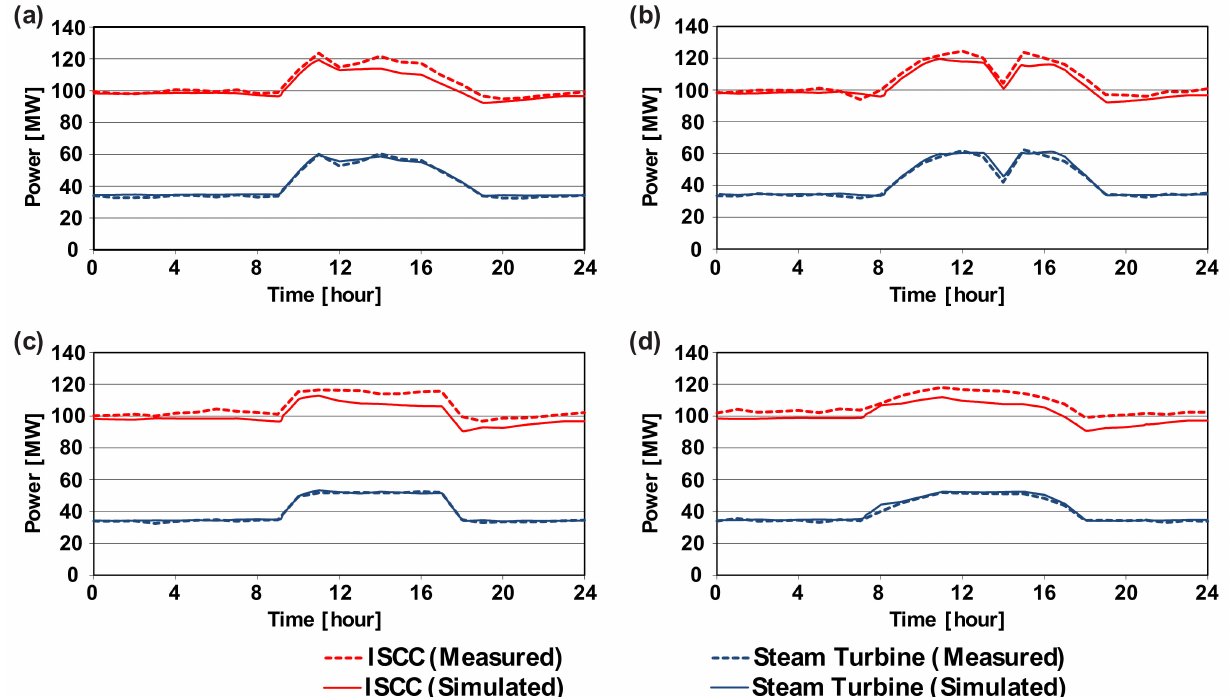
Figure 12. The electrical power output of the ISCC power plant for four days: ( a ) 20 July 2013; ( b ) 21 July 2013; ( c ) 30 August 2013 and ( d ) 4 September